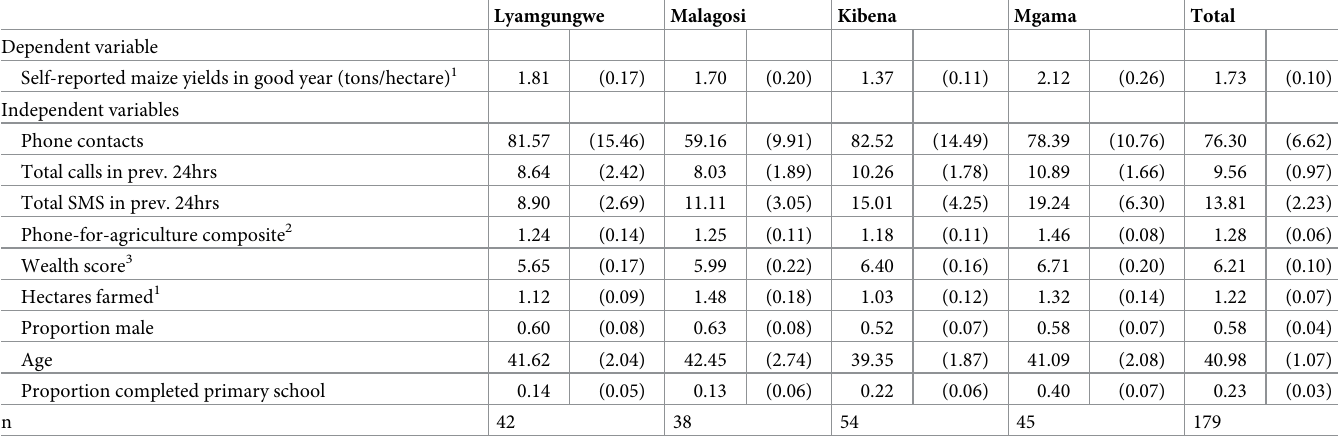
Table 1. Regression variable means (and standard errors) stratified by study village. Binary variables are reported as